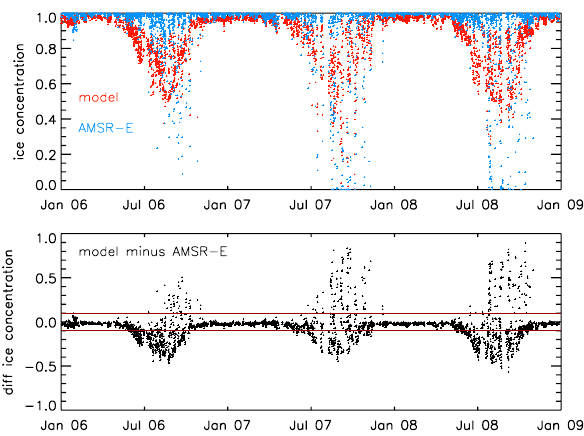
Fig. 2. Top: mean simulated and AMSR-E ice concentration within the cyclone radius for all 5057 detections. Bottom: difference be- tween mean simulated and AMSR-E ice concentration. Red line marks range of Adiff-filter.